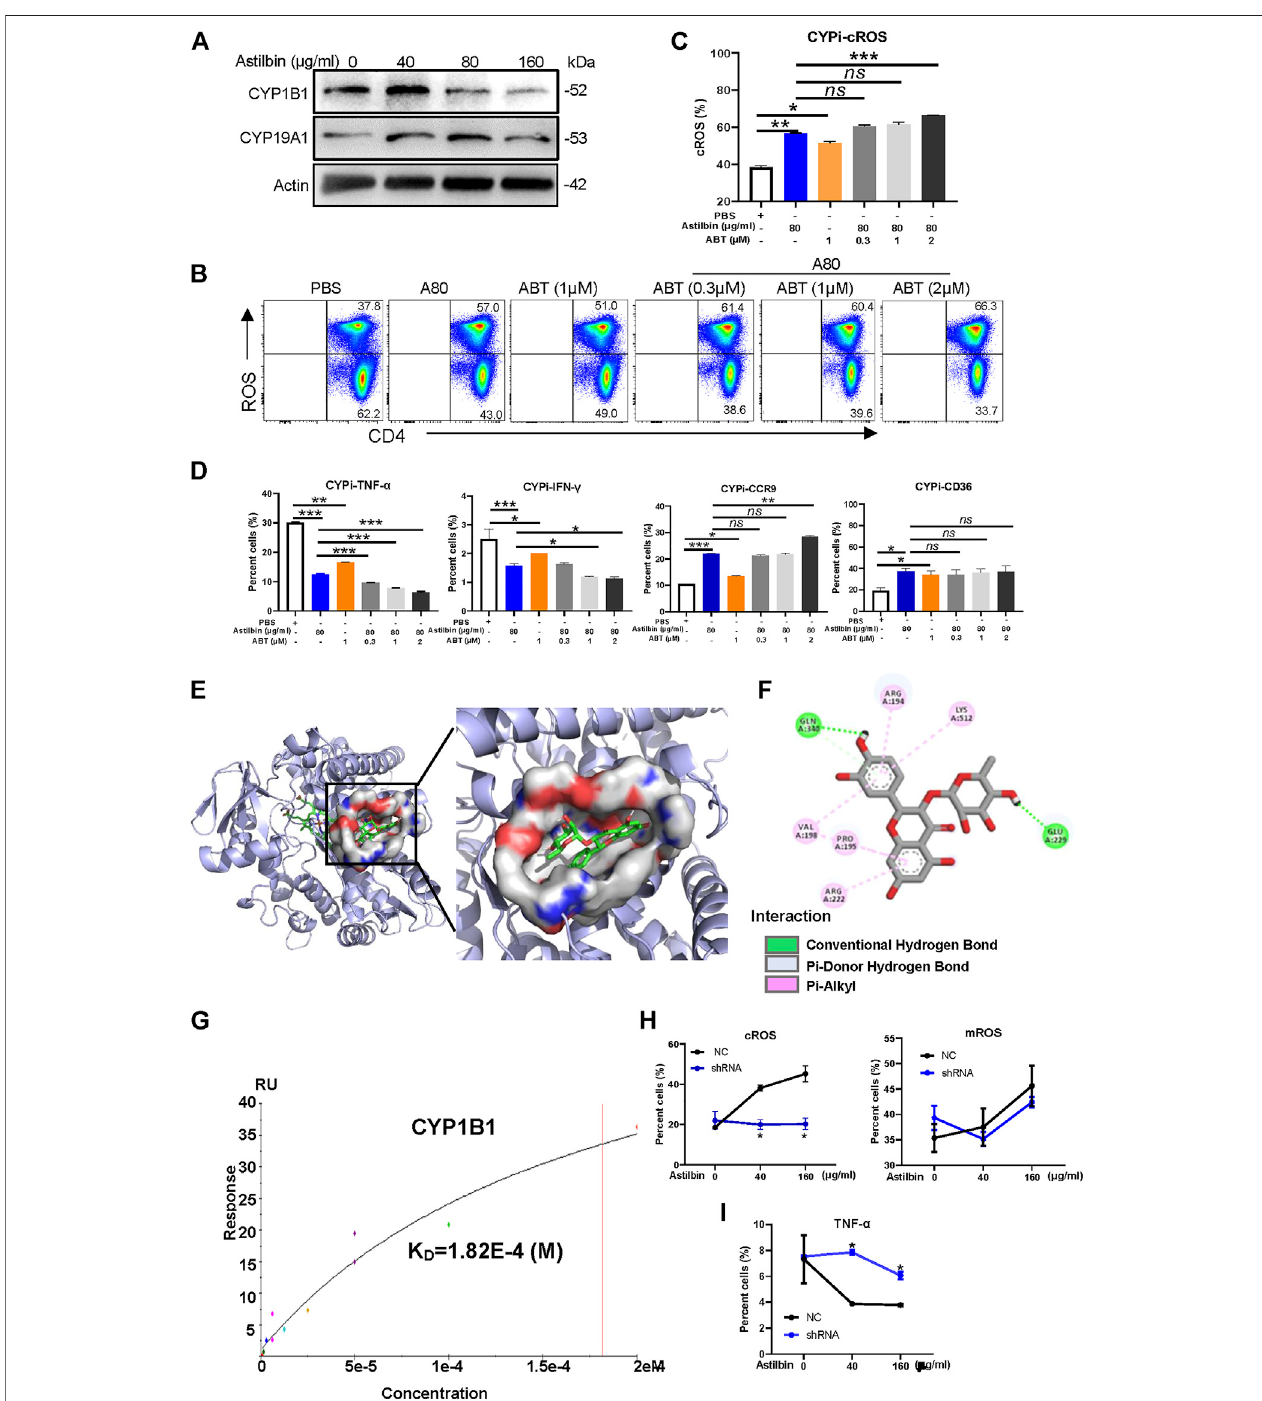
FIGURE7| CYP1B1providesadocksiteforastilbin. (A) VariationsofCYP1B1andCYP19A1inastilbin-treatedCD4 + Tcells. (B,C) AstilbinpromotescellularROS production similar to ABT (a non-speci fi c inhibitor of CYP). Mean ± SD; n = 3. (D) Effects of astilbin on IFN- γ , TNF- α , CD36, and CCR9 of CD4 + T cells similar to ABT. Mean ± SD; n = 3. (E) Three-dimensional model of the CYP1B1 active site with bound astilbin. (F) Binding of CYP1B1 with astilbin and the inset showing the principal interactive residues of astilbin at the CYP1B1 binding pocket. Green dashed lines represent hydrogen bonds. The hydrophobic interaction is depicted by pink dashed lines. (G) RealbindingofCYP1B1withastilbin con fi rmedbySPRassay.Production ofcROSandmROS (H) and TNF- α (I) inCYP1B1shRNA-transfectedCD4 + T cells. Mean ± SEM; n = 3. All experiments were performed three times. The inhibitor ofCYP, ABT, is abbreviated as CYPi. p values (* p ≤ 0.05; ** p ≤ 0.01; *** p ≤ 0.001; ns, no signi fi cant difference) determined by one-way ANOVA (C,D) and two-way ANOVA (H,I) .